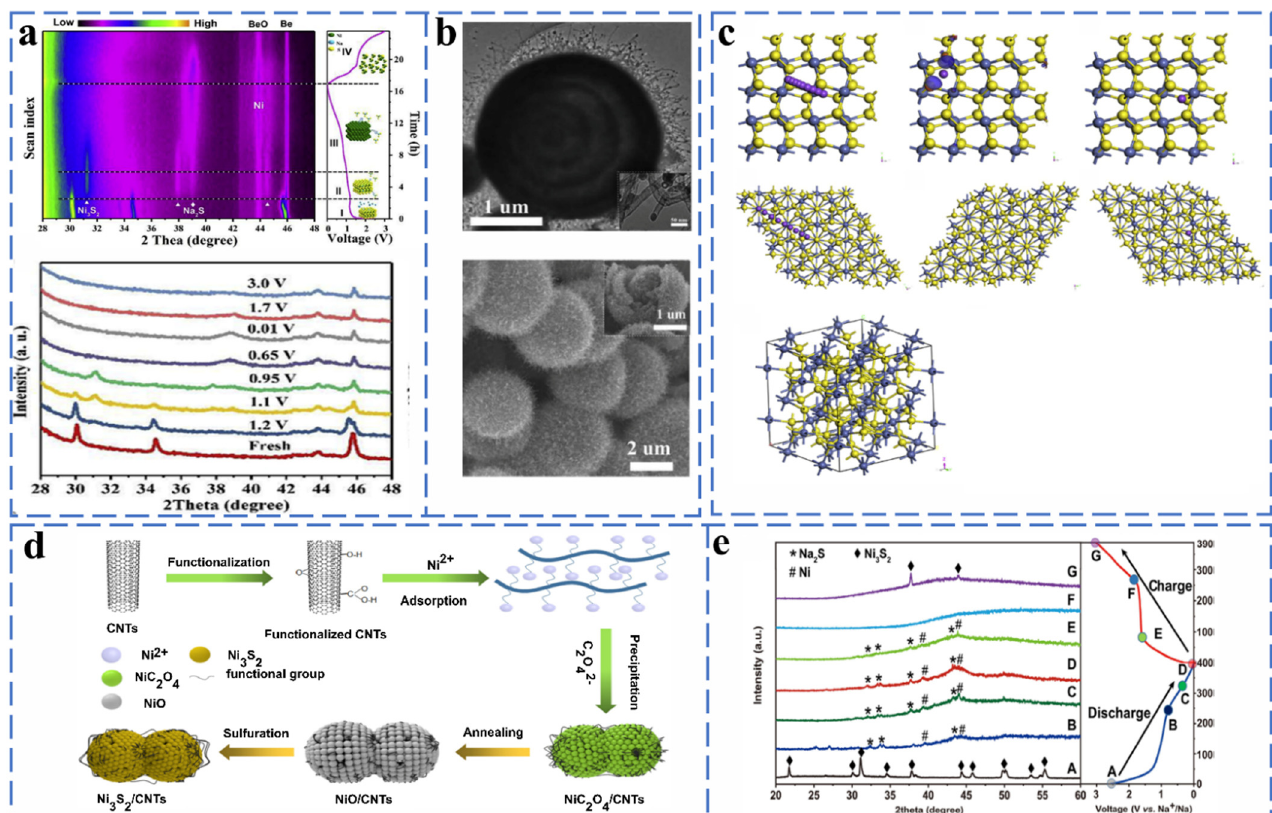
Figure 14. ( a ) In situ XRD patterns during the first charge and discharge process and XRD patterns at different discharge–charge stages of the NiS@NCNT MSHMs electrodes. ( b )TEM and SEM image. Reprinted with permission from [92]. Copyright 2018 copyright Fang, Y. ( c ) Geometric models for Na ion migration pathways on the NiS 2 (100) surface and NiS 2 (111) surface of top views and optimized geometry structures of NiS 2 and corresponding diffusion energy barrier profiles on different surfaces. Reprinted with permission from [93]. Copyright 2021 copyright Wei, X. ( d ) The synthetic procedure of Ni 3 S 2 /CNTs micro-nanostructure composites. ( e ) Ex situ XRD curves of Ni 3 S 2 /CNTs-10 electrode at different states in the first cycle. Reprinted with permission from [94]. Copyright 2019 copyright Li,